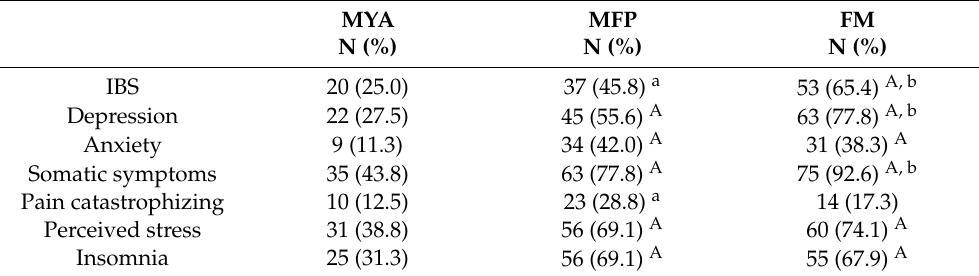
Table 2. Presence of self-reported comorbid conditions in each study group based on questionnaires. Data are presented as number (%) of participants with the specific comorbid